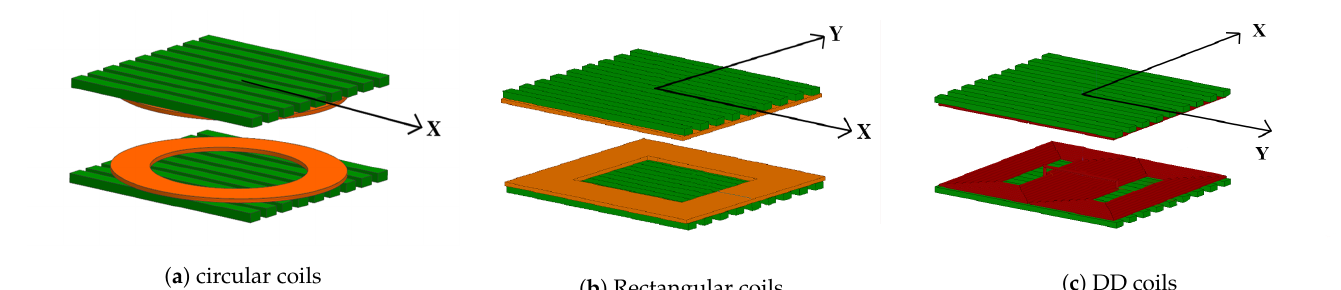
Figure 6. Coil modeling and direction definitions.